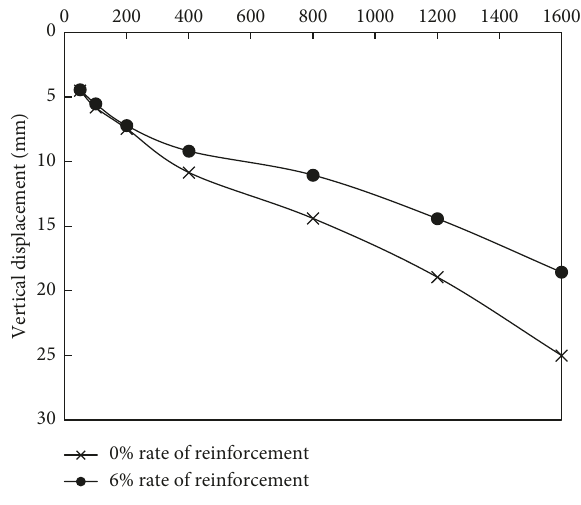
Figure 6: Vertical load-displacement